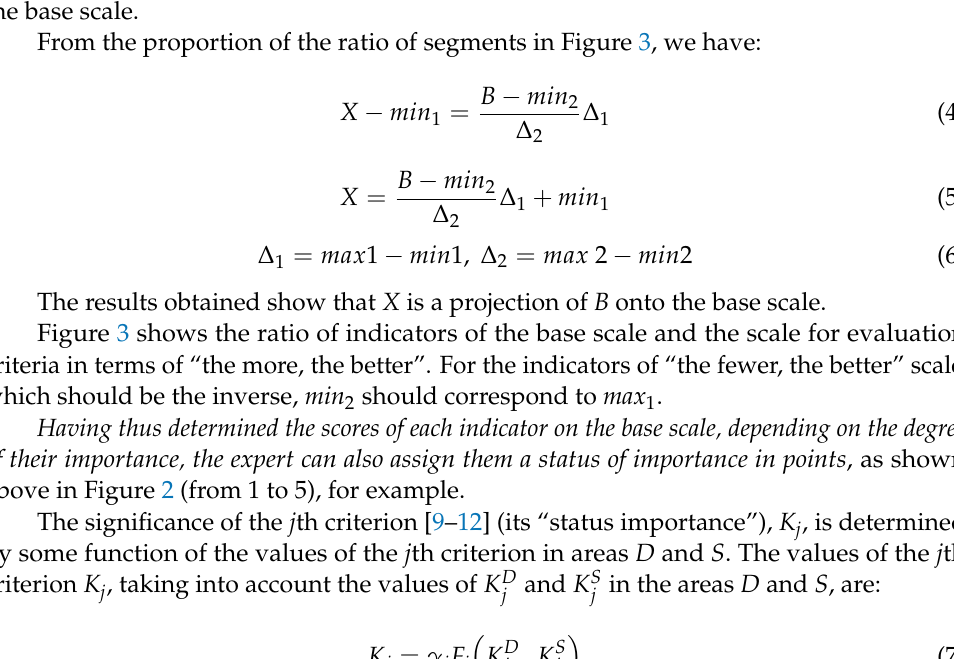
Figure 3. Base scale calculation scheme (source: designed by authors).